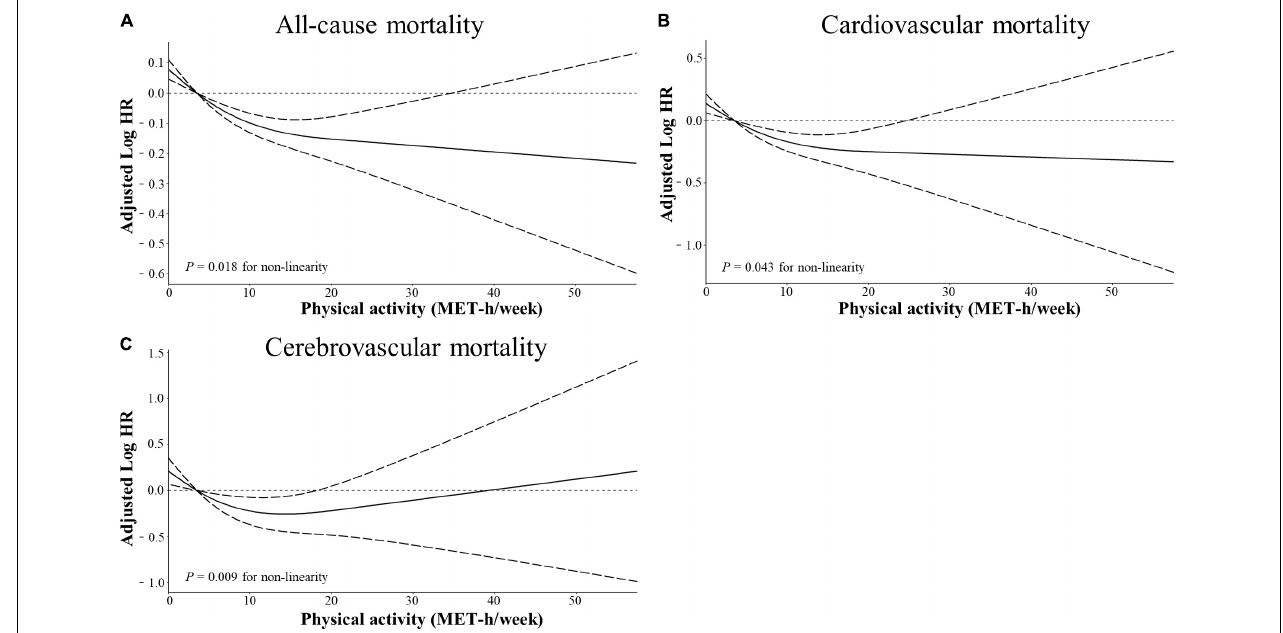
FIGURE 4 | Restricted cubic spline models for the association between physical activity and adverse outcomes. Adjusted log 10 hazards ratio (solid lines) and 95% confidence intervals (dashed lines) after controlling covariates in Table 1 for (A) all-cause mortality, (B) cardiovascular mortality, and (C) cerebrovascular mortality, compared with total physical activity volume quantified in metabolic equivalent hours per week (MET-h/week). Splines were examined in the fully adjusted model with the best placed knots at the 5, 35, 65, and 95th percentiles of physical activity